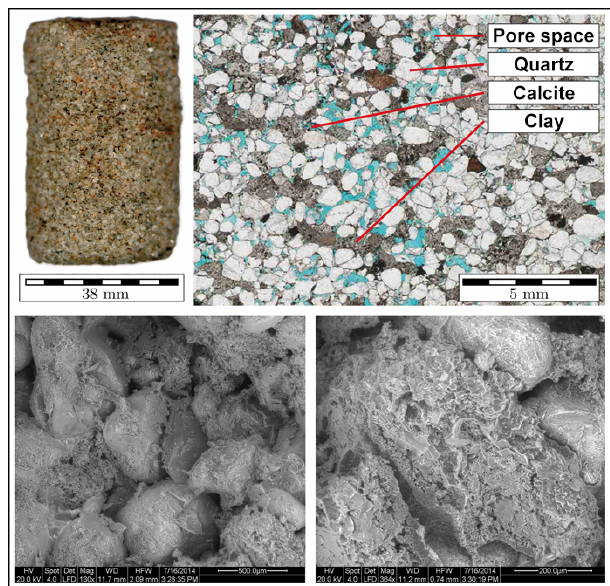
Figure 1. Top left: photograph of a well core sample. Top right: thin section image of the sample confirming the well sorted and rounded character. Labels mark the main mineral components quartz, calcite, clay and the pore space. Bottom left: SEM image showing a plane view on a mineral conglomerate of quartz grains interconnected by clayey and carbonatic cement. Bottom right: SEM image highlight- ing the partially significant amount of cementation (modified from Tatomir et al.,